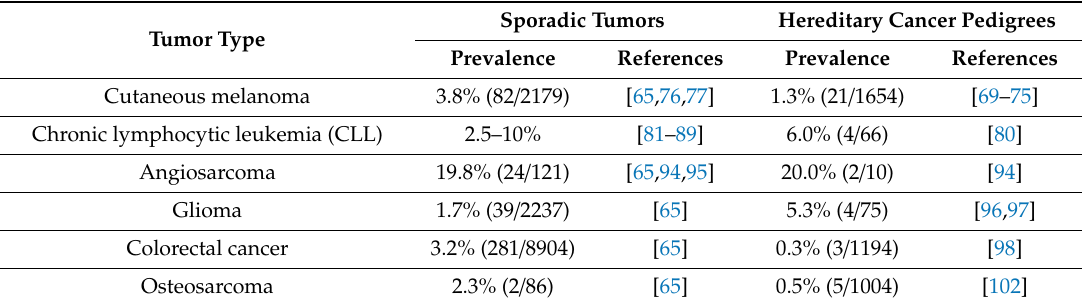
Table 1. Prevalence of germline and sporadic POT1 mutations in selected cancer